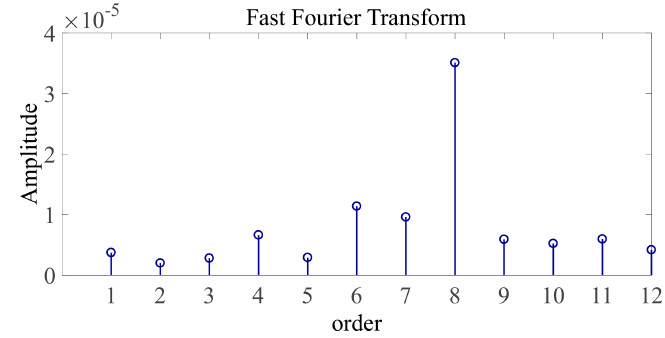
Figure 5. Order distribution after speed normalization (using a rotation speed of 3000 rpm as an